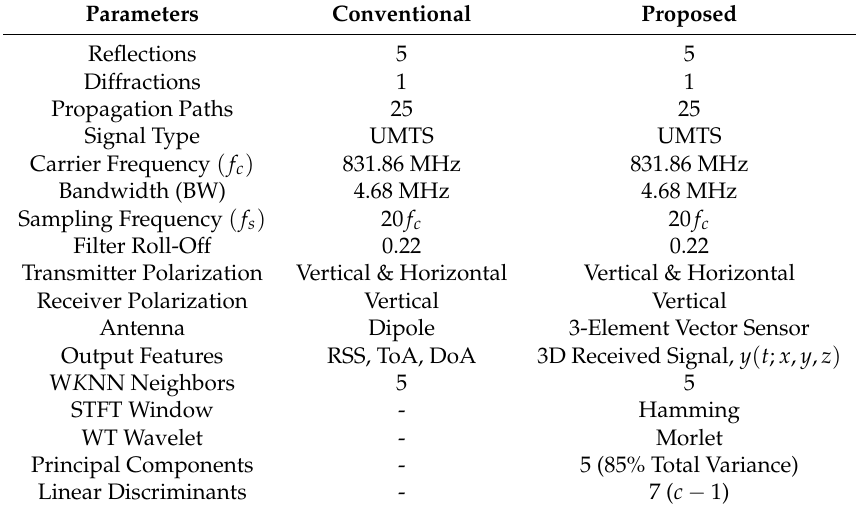
Table 1. Parameters Defined in the Wireless InSite R (cid:13)